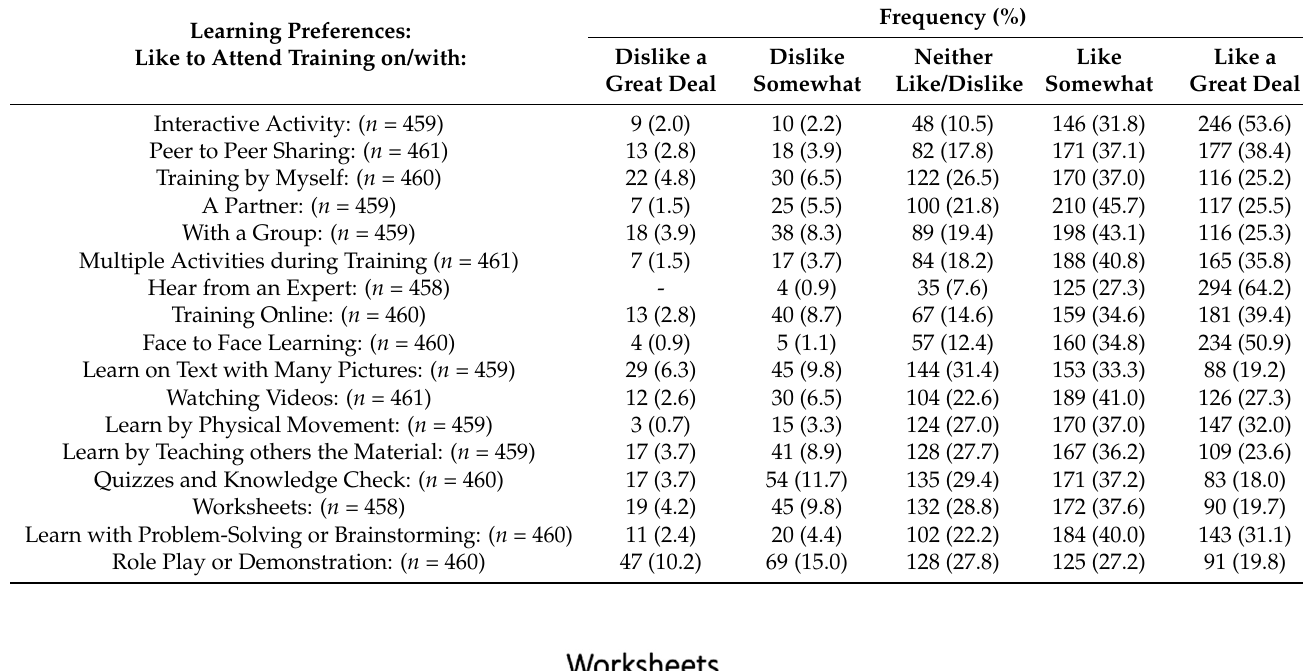
Table 2. Reported Preferred Learning Methods of Illinois Child Nutrition Program staff.